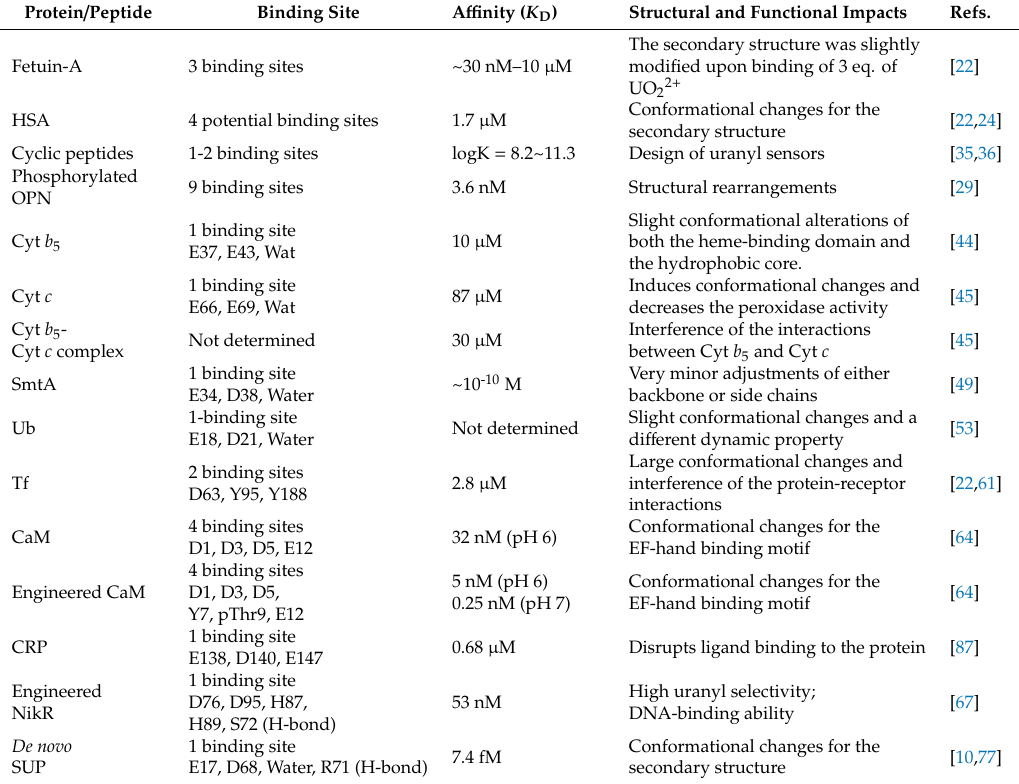
Table 1. Uranyl binding to some proteins or peptides and the structural-functional impacts. Protein /